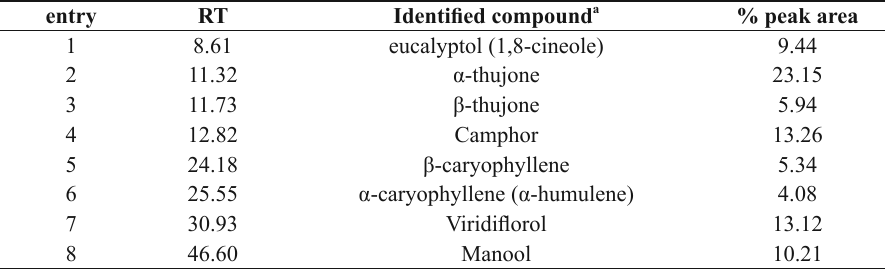
Major constituents expressed as peak area percentage of hydroalcoholic extract of S. of fi cinalis identi fi ed by GC-MS analysis.